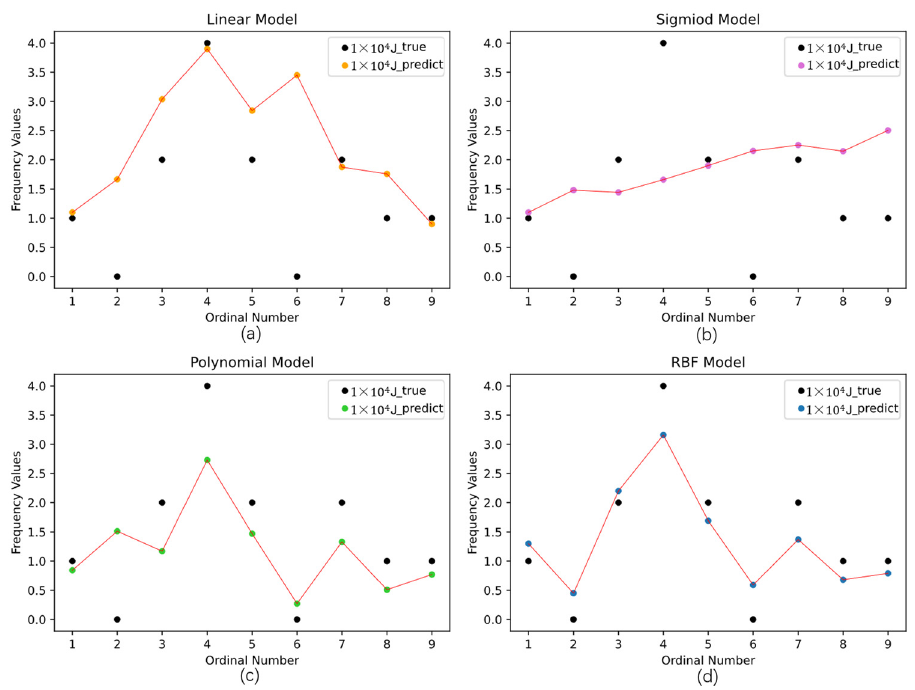
Figure 15. Prediction of SVR with different kernel functions on daily frequency of 10 4 J level. ( a ) Linear kernel. ( b ) Sigmoid kernel. ( c ) Polynomial kernel. ( d ) RBF kernel.